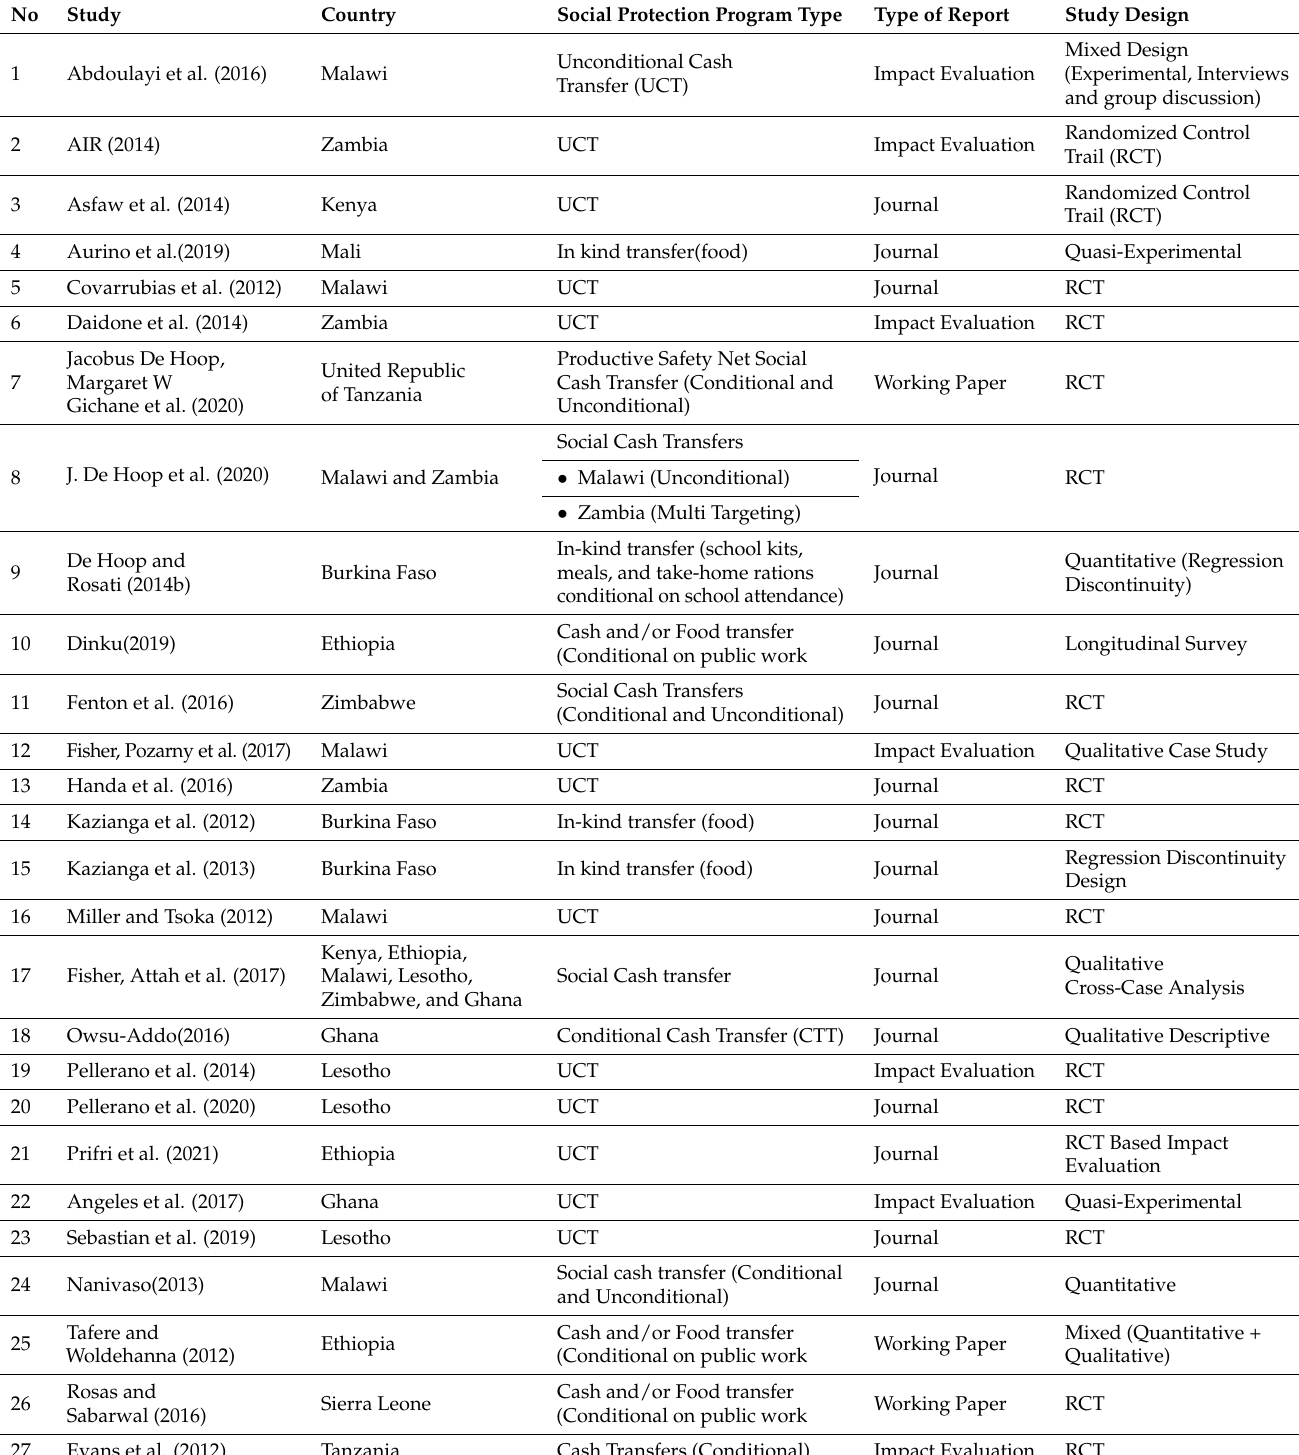
Table 2. Characteristics of studies included (n =